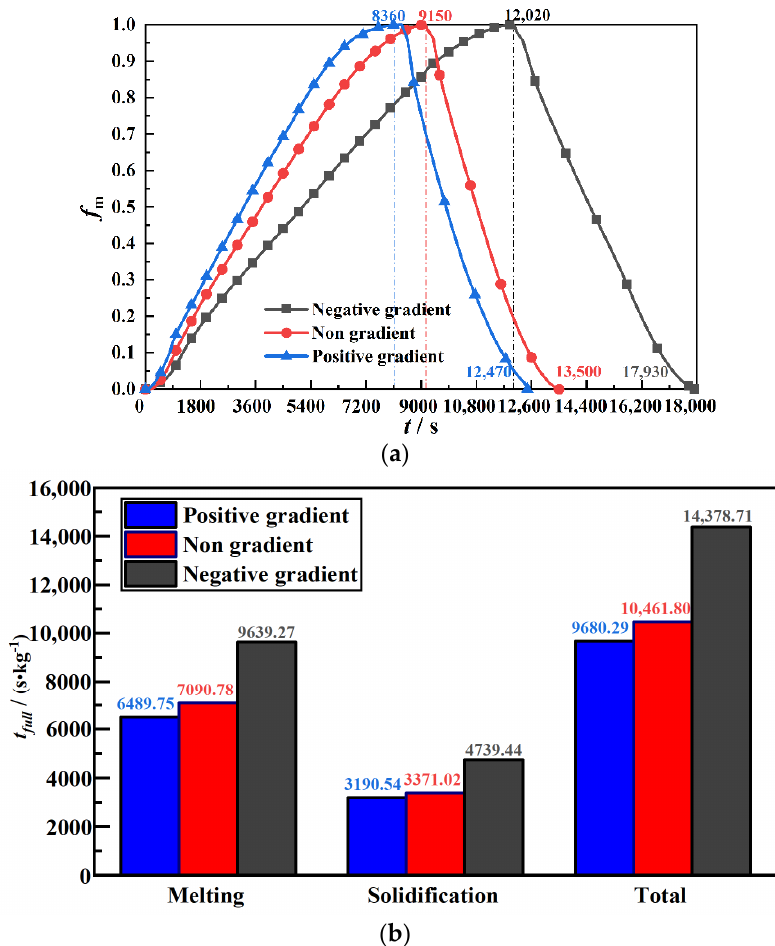
Figure 4. Phase transition characteristics for the three structures: ( a ) liquid phase rate curve with time; ( b ) unit mass phase transition